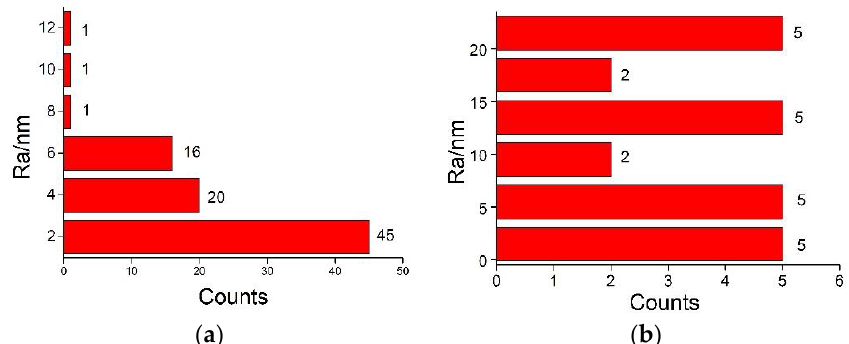
Figure 6. Roughness distribution. ( a ) correlation length 0.23 μm; and ( b ) correlation length 1 μm.